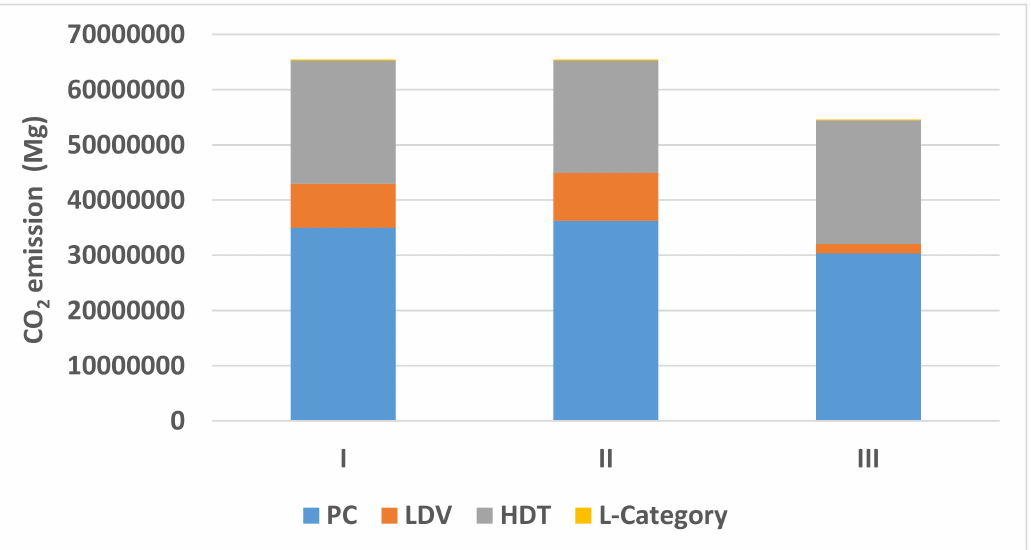
Figure 2. Emissions for three